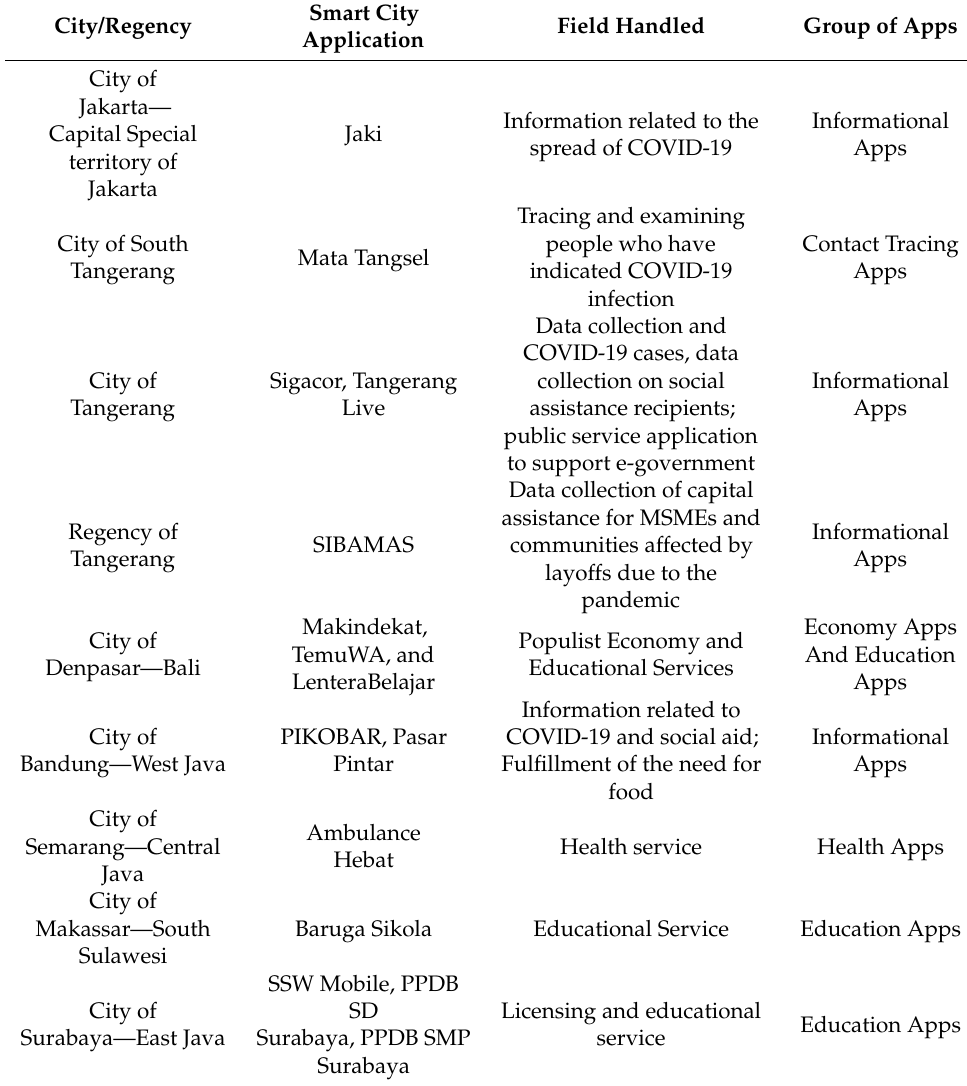
Figure 2. Distribution map of cities and regencies that are included in the 100 Smart City movement in Indonesia. Source: [43]. Table 2. List of applications used to handle COVID-19 in several Indonesian smart